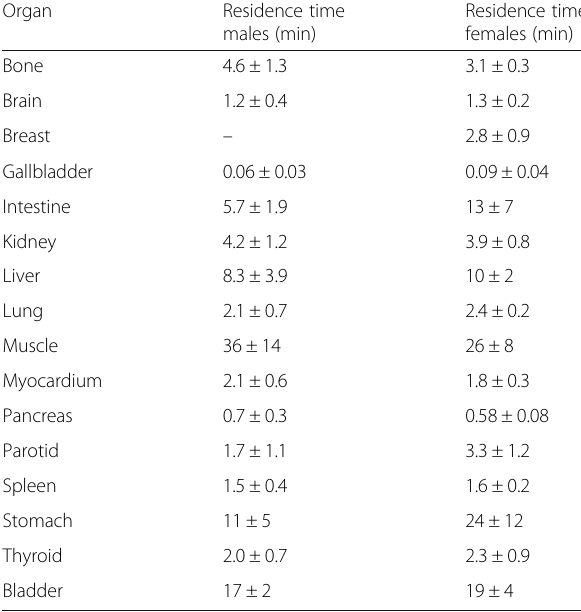
Table 4 Organ residence times of 18 F-TFB in healthy participants